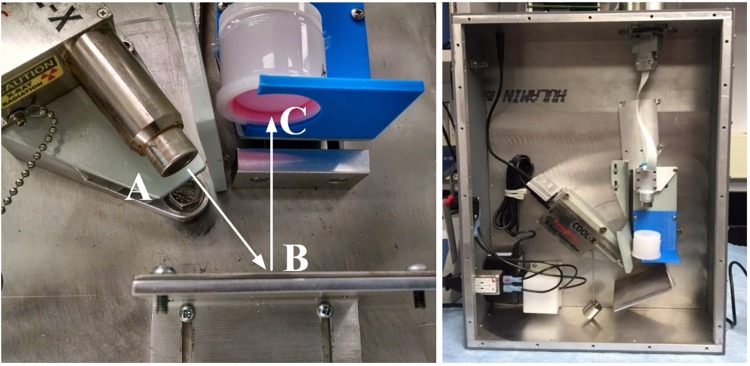
X-ray irradiator setup.The radiation source (A) targeted the cell culture by fluorescing off the metal plate (B) before irradiating the culture through the Mylar® from the base of the cup (C).